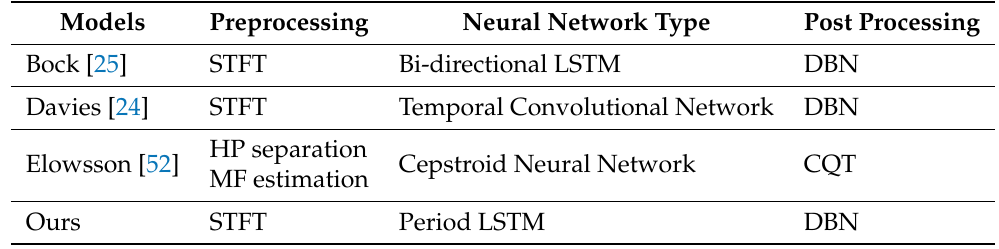
Table 1. Comparison table between the proposed method and other state-of-the-art